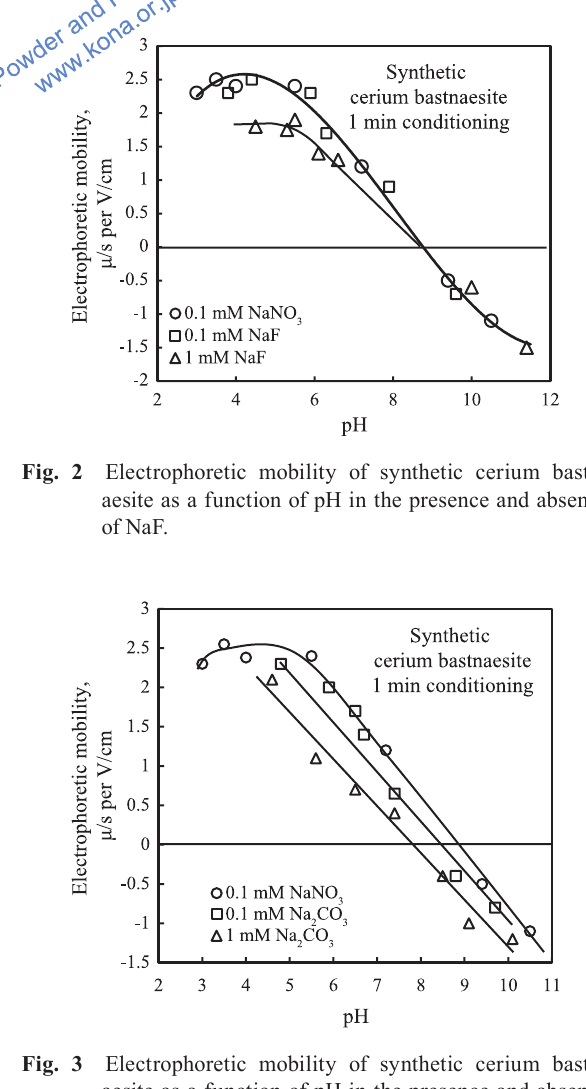
Fig. 5 Change of net charge with pH in the synthetic cerium bastnaesite/water system in equilibrium with the atmo - sphere at 25°C (room